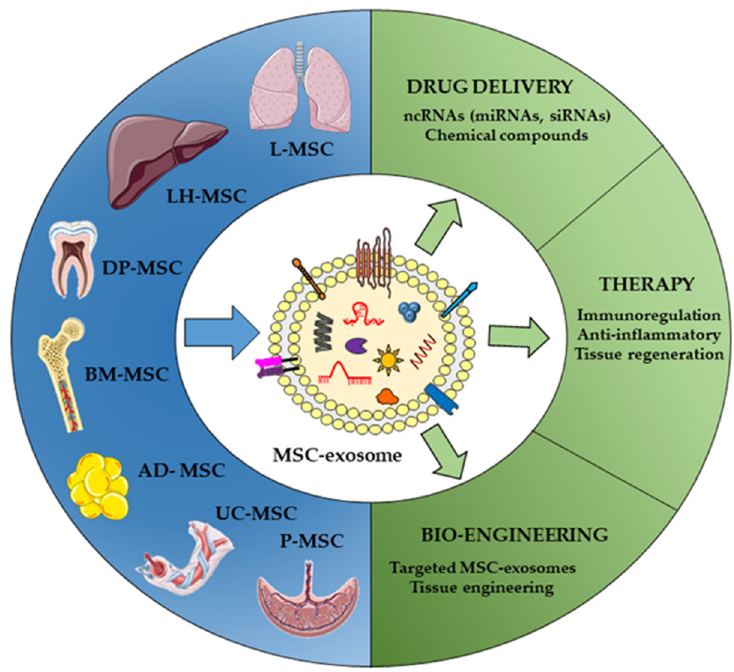
Figure 2. Origin and therapeutic purposes of mesenchymal stem cells (MSC) and MSC-derived exosomes (MSC-Exos). MSCs are found in many tissues, such as lung (L), liver (LH), dental pulp (DP), bone marrow (BM), adipose tissue (AD), umbilical cord (UC) and placenta (P). MSC-Exos play therapeutic roles as drug delivery systems (targeted MSC-exos) for immunomodulation, an-ti- inflammatory effect and tissue regeneration and engineering. Created mainly in biorender.com.